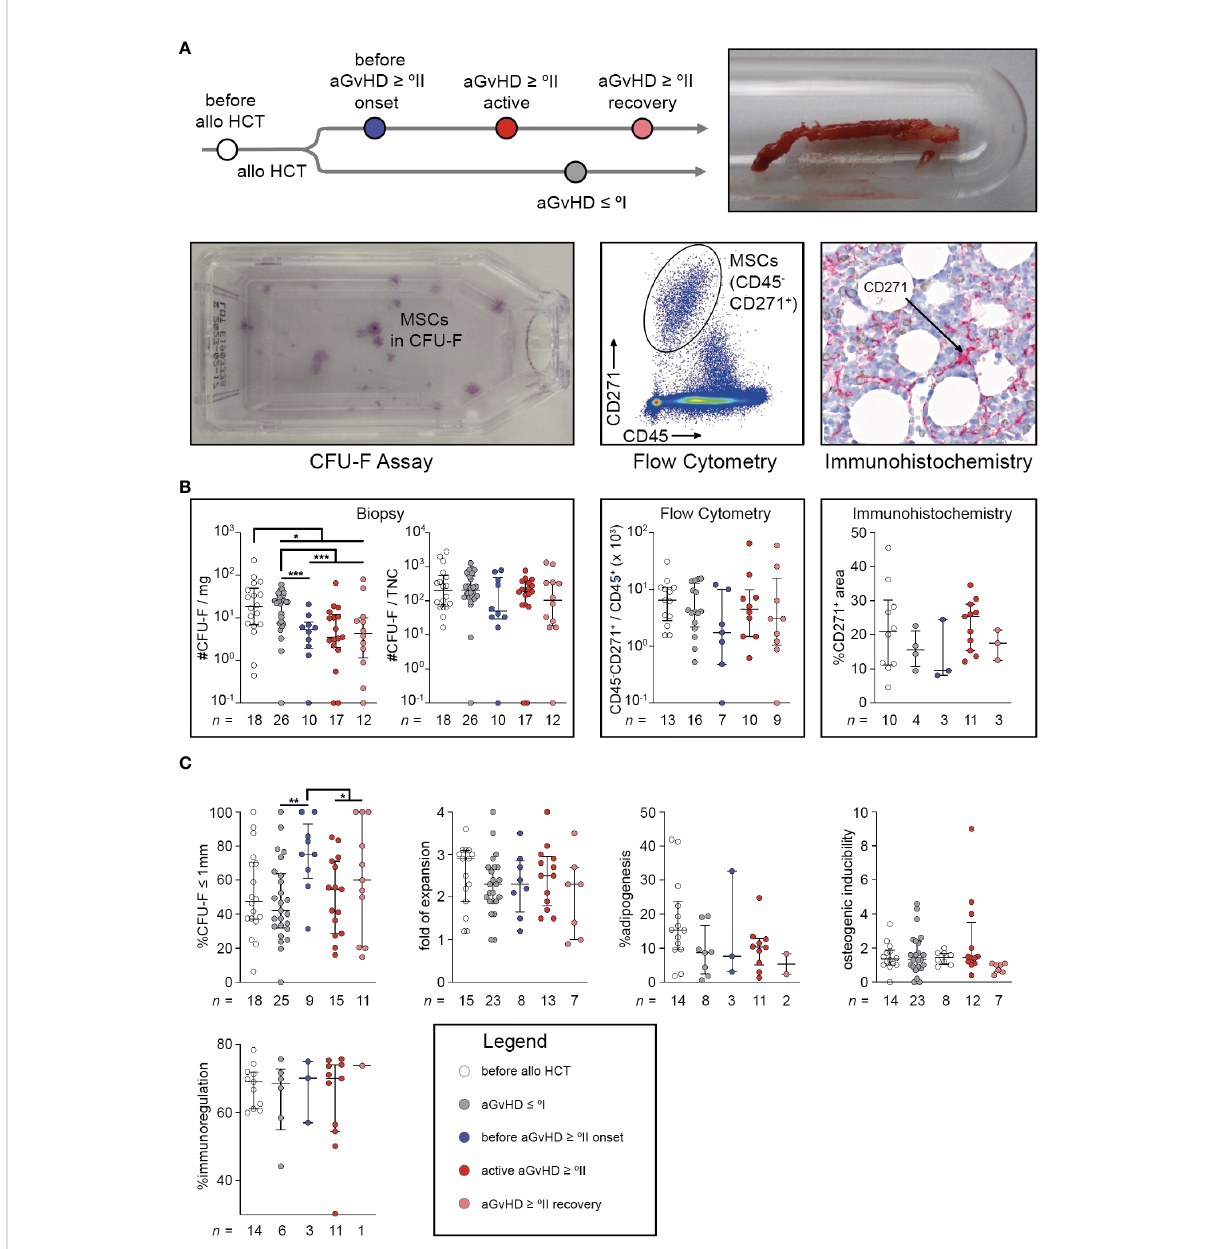
FIGURE 1 Quantity of mesenchymal stromal cells and their size of fi broblastic colony-forming units coincide with moderate to severe acute graft-versus- host-disease. (A) Study design: trephine biopsy specimens were obtained from routine diagnostics. After collagenase digestion, cells were seeded for CFU-F assay or stained to identify CD45 - CD271 + cells using MFC, after gating on PI − CD235a − single cells. Trephine biopsies from routine diagnostics were also used for immunohistological staining and calculation of CD271 + area (black arrows) related to total cellularized area. (B) CFU- F capacity related to the trephine biopsy ’ s weight and related to TNC, freshly isolated uncultured MSCs de fi ned as PI − CD235a − CD45 − CD271 + related to non-erythroid hematopoietic cells de fi ned by PI − CD235a − CD45 + and quanti fi cation of MSCs using immunohistochemistry are shown. (C) The proportion of small colonies ( ≤ 1 mm) in CFU-F assays derived from MSC P0, population doubling time of MSC P1, the percentage of adipogenic different sites of MSC P2 layers, the osteogenic inducibility of MSC P2 layers (units of alkaline phosphatase of differentiated wells related to undifferentiated controls) and the immunomodulatory capacity of MSC P2 (T cell proliferation in cocultures with irradiated MSC P2 related to monocultures after anti-CD3/CD28 bead activation) are illustrated. The graphs show individual values with median and interquartile ranges. The Mann-Whitney U-tests were used for statistical analyses. n, number; * P < 0.05, ** P < 0.01, *** P <